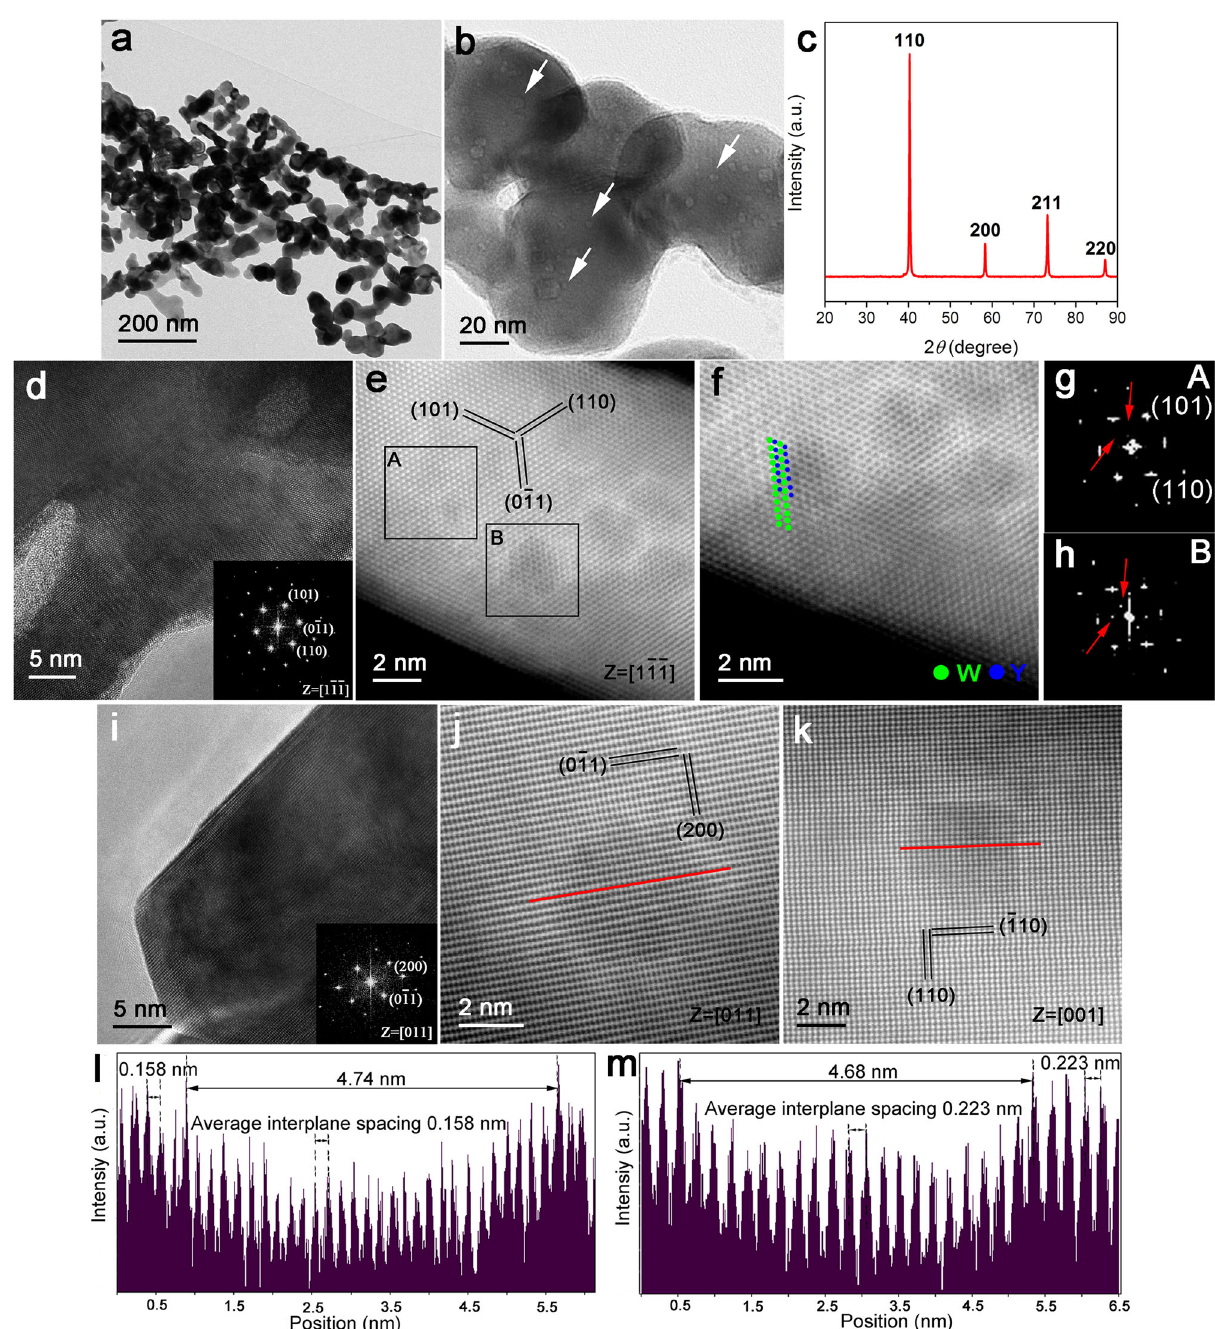
Fig. 4 XRD, TEM, and HAADF STEM image of oxide@W core-shell structural composite powder. a TEM image of composite powder showing its homogeneous size distribution. b TEM image revealing the distribution of intragranular oxide nanoparticles (indicated by white arrows). c XRD pattern of core-shell composite powder. d HRTEM image of a powder grain taken from 〈 111 〉 zone axis revealing the highly coherent interface between oxide nanoparticle and W matrix The inset shows the SAED pattern of the corresponding microstructure. e HAADF STEM image showing a few coherent oxide nanoparticles. f The enlarged image of e highlighting the periodic atomic columns in oxide nanoparticles. W and Y atoms are denoted as green and blue circles, respectively, and superimposed on f . g, h The FFT patterns taken from the W matrix and oxide nanoparticles, respectively, revealing the presence of Y columns along the {110} plane of the W matrix. i HRTEM image of a powder grain taken from 〈 011 〉 zone axis similarly revealing the coherent interface relationship between oxide nanoparticles and W matrix The inset is the corresponding SAED pattern. j , k HAADF STEM images taken from 〈 011 〉 and 〈 001 〉 zone axis, respectively, revealing the presence of Y columns along the {110} plane of W matrix. l , m The intensity pro fi les taken along the red line in j and k , respectively. The periodic strong peaks on both sides represent W columns in the W matrix and the weak peaks lowered by Y atoms denote the W columns in oxide